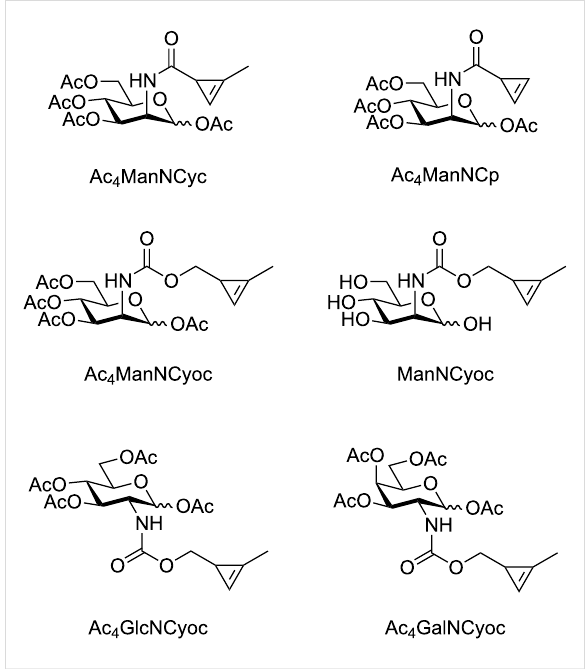
Figure 1: Cyclopropene-modified mannosamine, glucosamine and galactosamine derivatives employed for